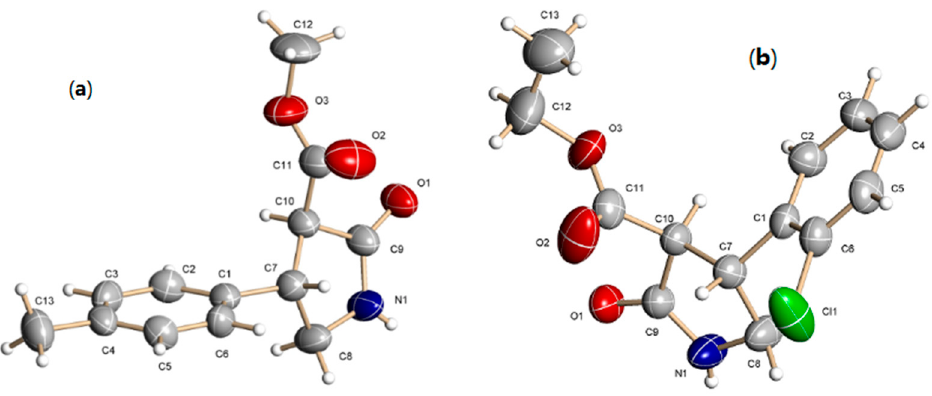
Figure 2. X-ray structures of γ -lactams 7c ( a ) and 7e ( b ).